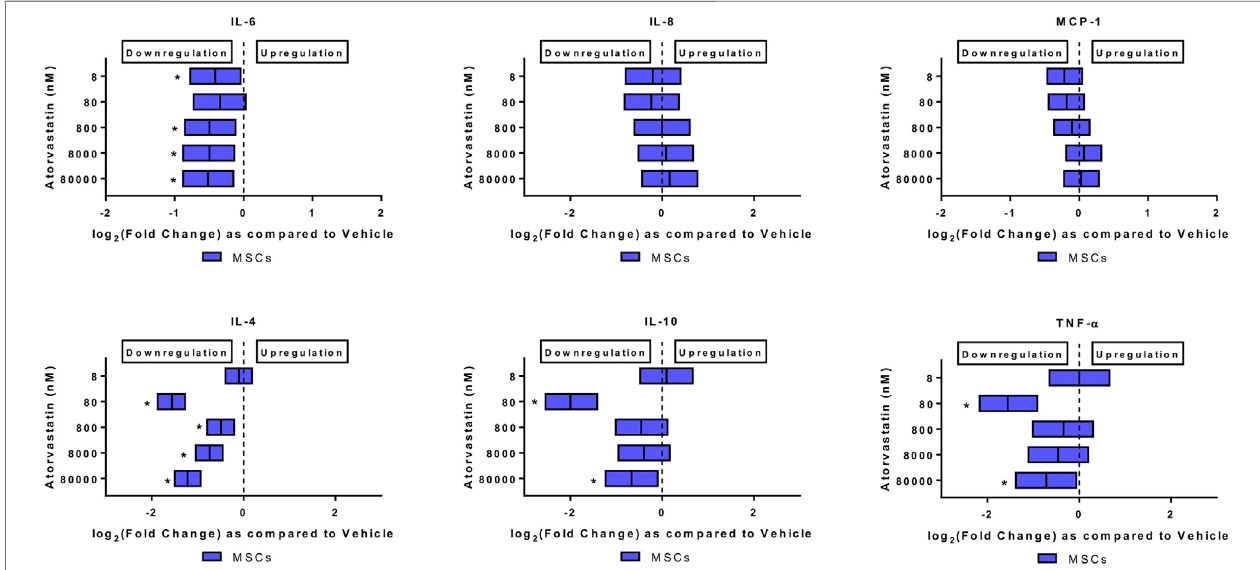
FIGURE2| AtorvastatinaltersthesecretomeofMSCsafter24 hofexposure.AtorvastatindecreasedIL-6,IL-4,IL-10andTNF- α secretionsfromMSCsafter24 h of exposure. Signi fi cance is shown by * p < 0.05.